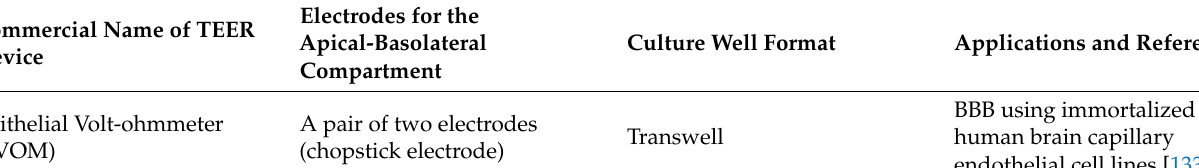
Table 2. List of commercial biosensors and their applications in the assessment of cellular barrier